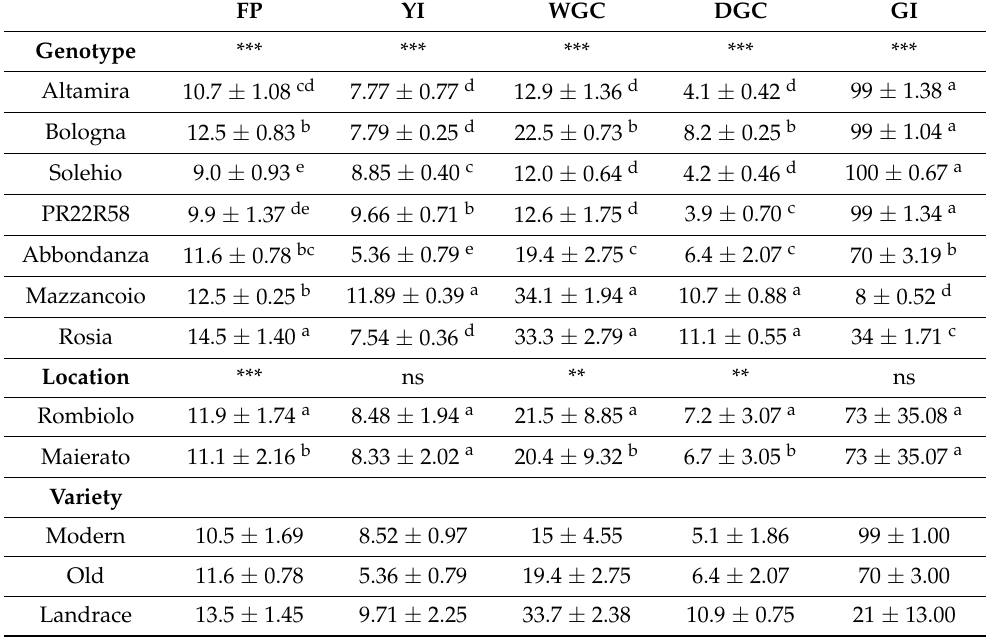
Table 3. Flour quality characteristics.